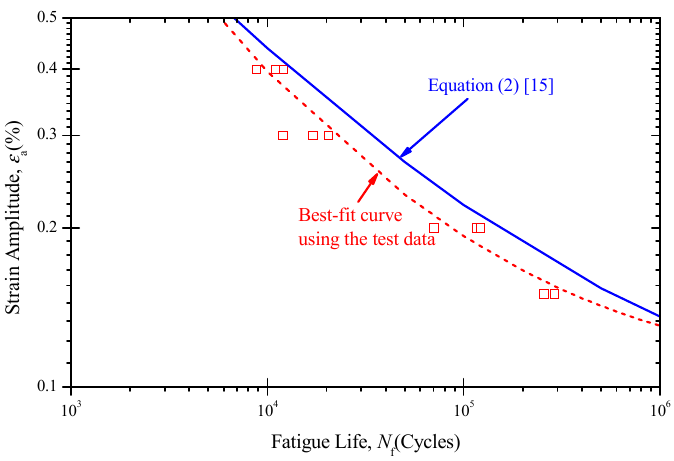
Figure 7. Test data for steam generator (SG) tubes.